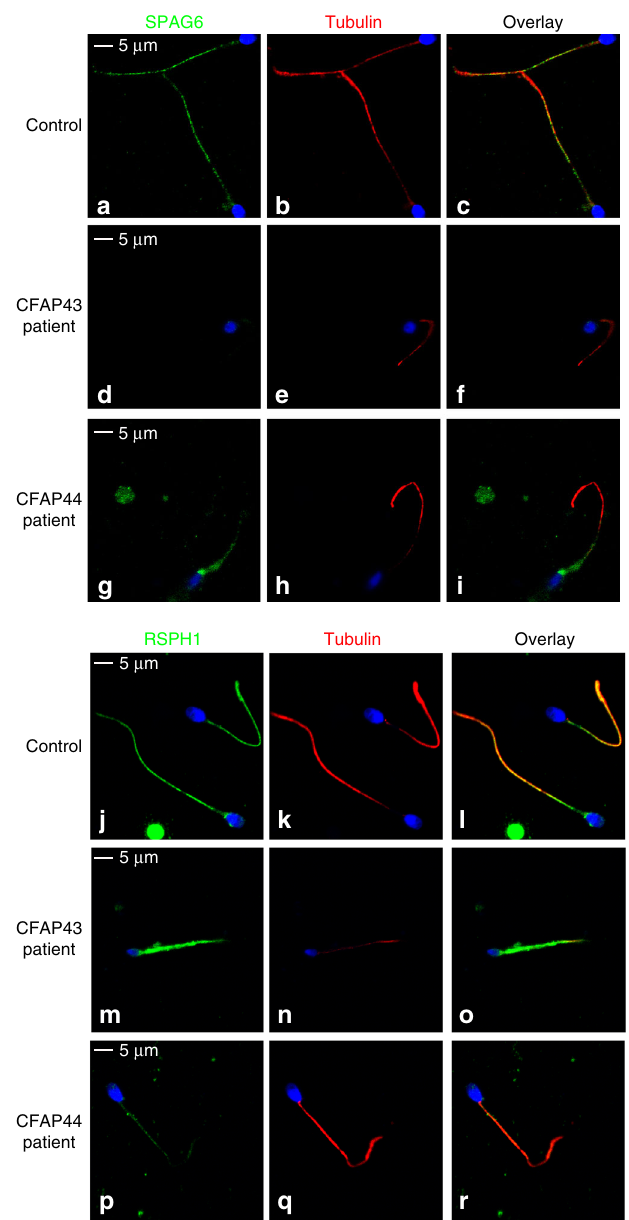
Fig. 3 Immuno fl uorescence staining in CFAP43 and CFAP44 patients reveals an abnormal axonemal organization. a – c sperm cells from a fertile control stained with anti SPAG6 (green), a protein located in the CPC, and anti-acetylated tubulin (red) antibodies. DNA was counterstained with Hoechst 33342. c Corresponds to a and b overlay and shows that in control sperm, SPAG6 and tubulin staining superimpose. Scale bars = 5 µ m. d – f SPAG6 staining is absent in sperm from the patient P 43 -5 homozygous for the c.2658C > T variant in CFAP43 . d – i Similar IF experiments performed with sperm cells from the patient P 44 -2 homozygous for the c.3175C > T variant in CFAP44 . Scale bar = 5 µ m. Contrary to the control, the SPAG6 immunostaining (green) is abnormal with a diffuse pattern concentrated in the midpiece of the spermatozoa and is not detectable in the principle piece. j – l Sperm cells from a fertile control stained with anti RSPH1 (green), a protein of the radial spoke ’ s head, and anti- acetylated tubulin (red) antibodies. DNA was counterstained with Hoechst 33342. l corresponds to j and k overlay and shows that RSPH1 and tubulin staining superimpose in control sperm. Scale bar = 5 µ m. m – o In sperm from the patient P 43 -5, RSPH1 staining (green) is signi fi cantly different from control ( m ) with a marked diffuse staining. p – r In sperm from the patient P 44 -2 the intensity of the RSPH1 staining is strongly